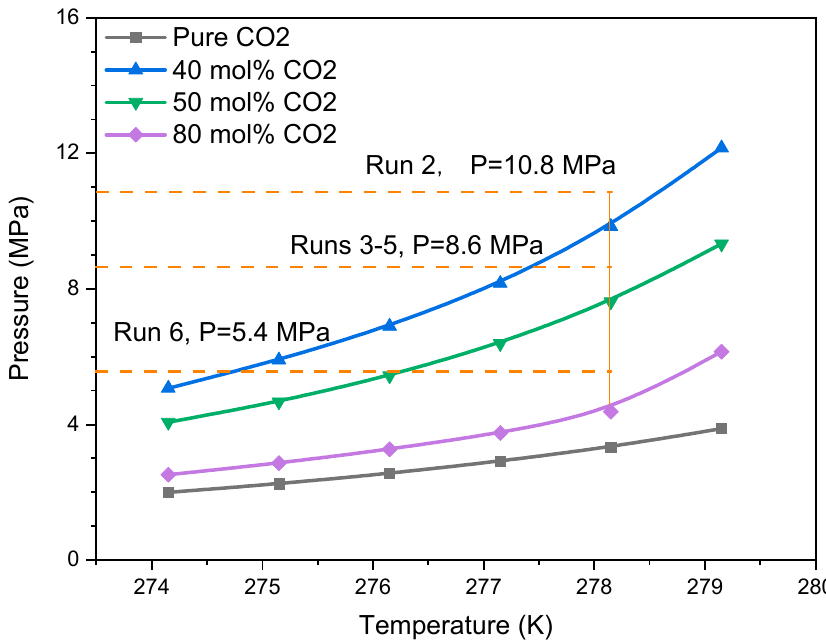
Figure 2. The data of the hydrate phase equilibrium. Table 1. Experimental conditions and results.